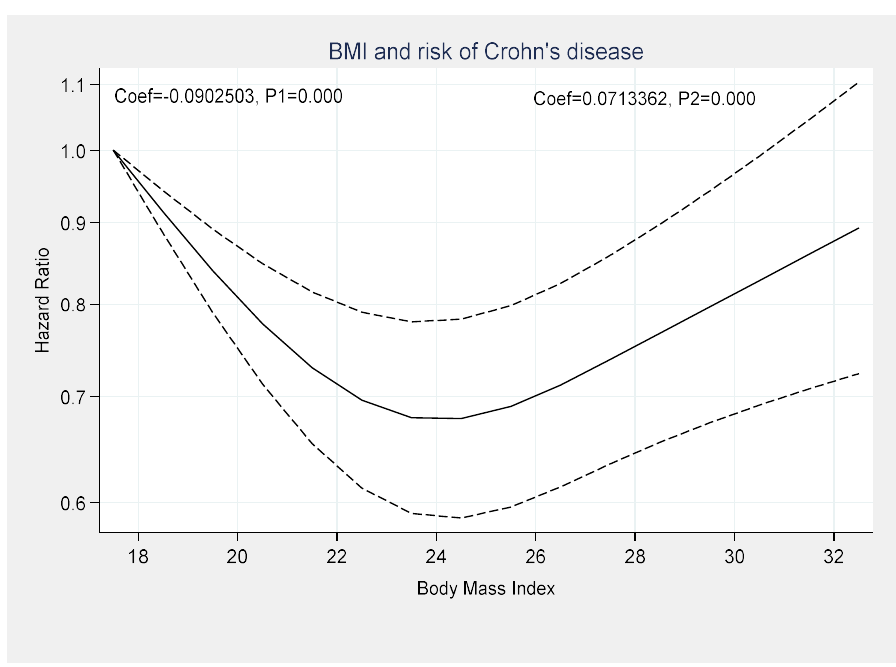
Figure 7. Dose–response association between BMI and development of Crohn’s disease. Figure 7. Dose-response association between BMI and development of Crohn’s However, there was no significant association between BMI and UC incidence (Coef1 = −0.0093, p 1 = 0.442 and Coef 2 = −0.0058, p 2 = 0.557) (Figure 8).